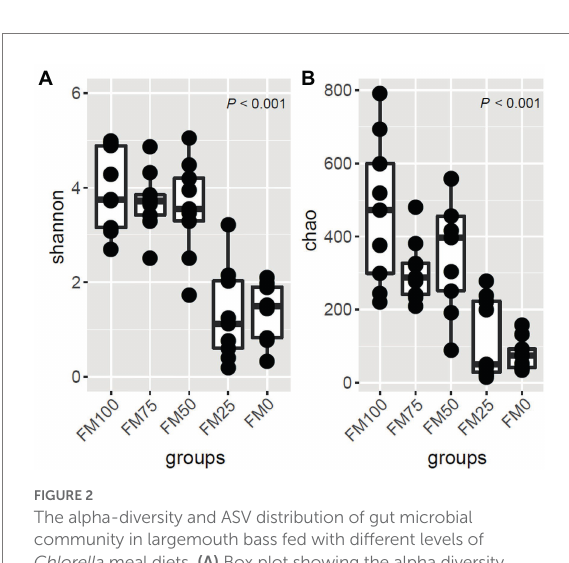
FIGURE 2 The alpha-diversity and ASV distribution of gut microbial community in largemouth bass fed with different levels of Chlorella meal diets. (A) Box plot showing the alpha diversity indices and (B) Venn diagram showing the shared ASVs and unique ASVs in the five treatments. FM100 represents the fishmeal diet without Chlorella meal; FM75, FM50, FM25 and FM0 represent the fishmeal feed with 25, 50, 75 and 100% fishmeal replacement by Chlorella meal,